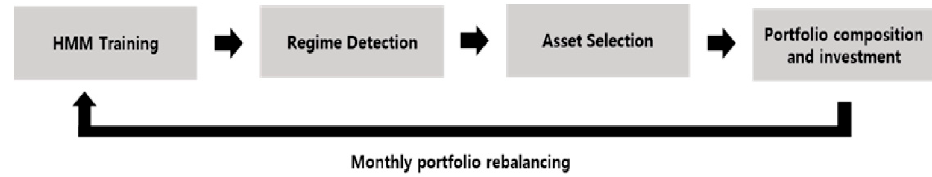
Figure 2. Empirical Analysis Model Figure 2 . Empirical Analysis Model Process. Figure 2 . Empirical Analysis Model Process.